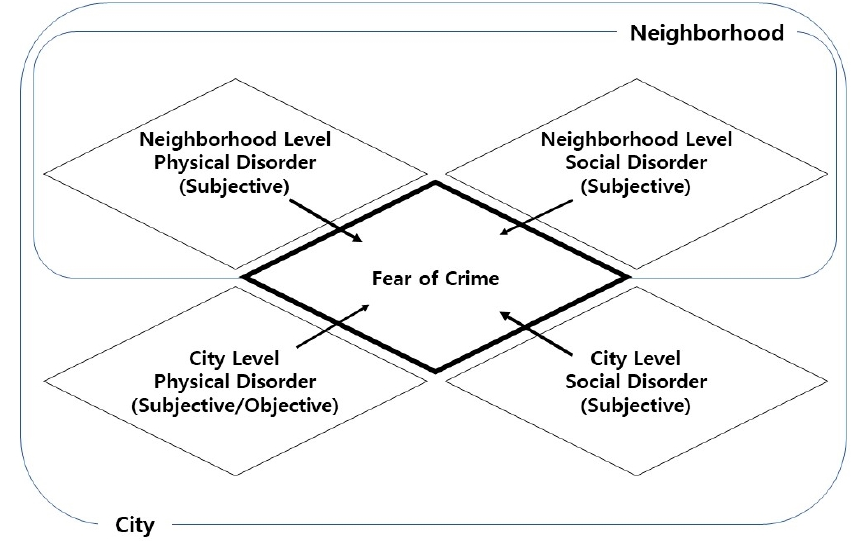
Figure 1. Multilayered relationship between disorder and fear of crime.